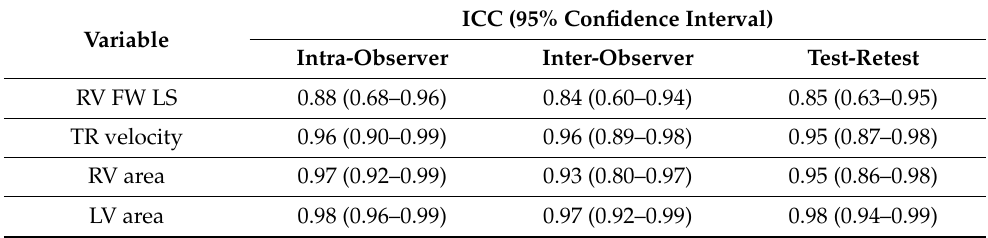
Table 5. Results of intra-observer, inter-observer, and test-retest reproducibility